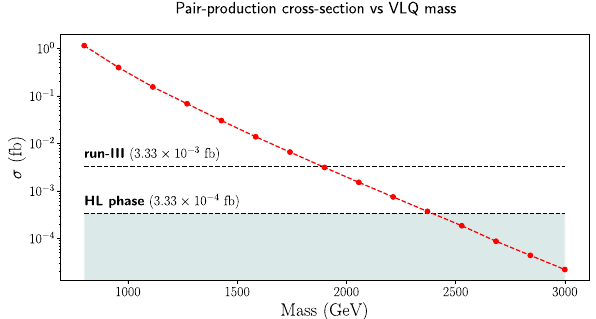
Fig. 3 The production cross-section (in femtobarn) as a function of the VLQ mass (in GeV). Two horizontal dashed lines are shown, one for the run-III target luminosity and the other for the HL phase of the LHC,whichrepresenttheminimalcrosssectionforwhichasingleevent can be produced, i.e. N exp = σ L = 1 for the dashed lines. The area filled in gray represents the region where neither the HL-LHC or run-III LHC have the required sensitivity to detect the D -VLQ for the chosen benchmark (2.5). The y -axis is shown in logarithmic